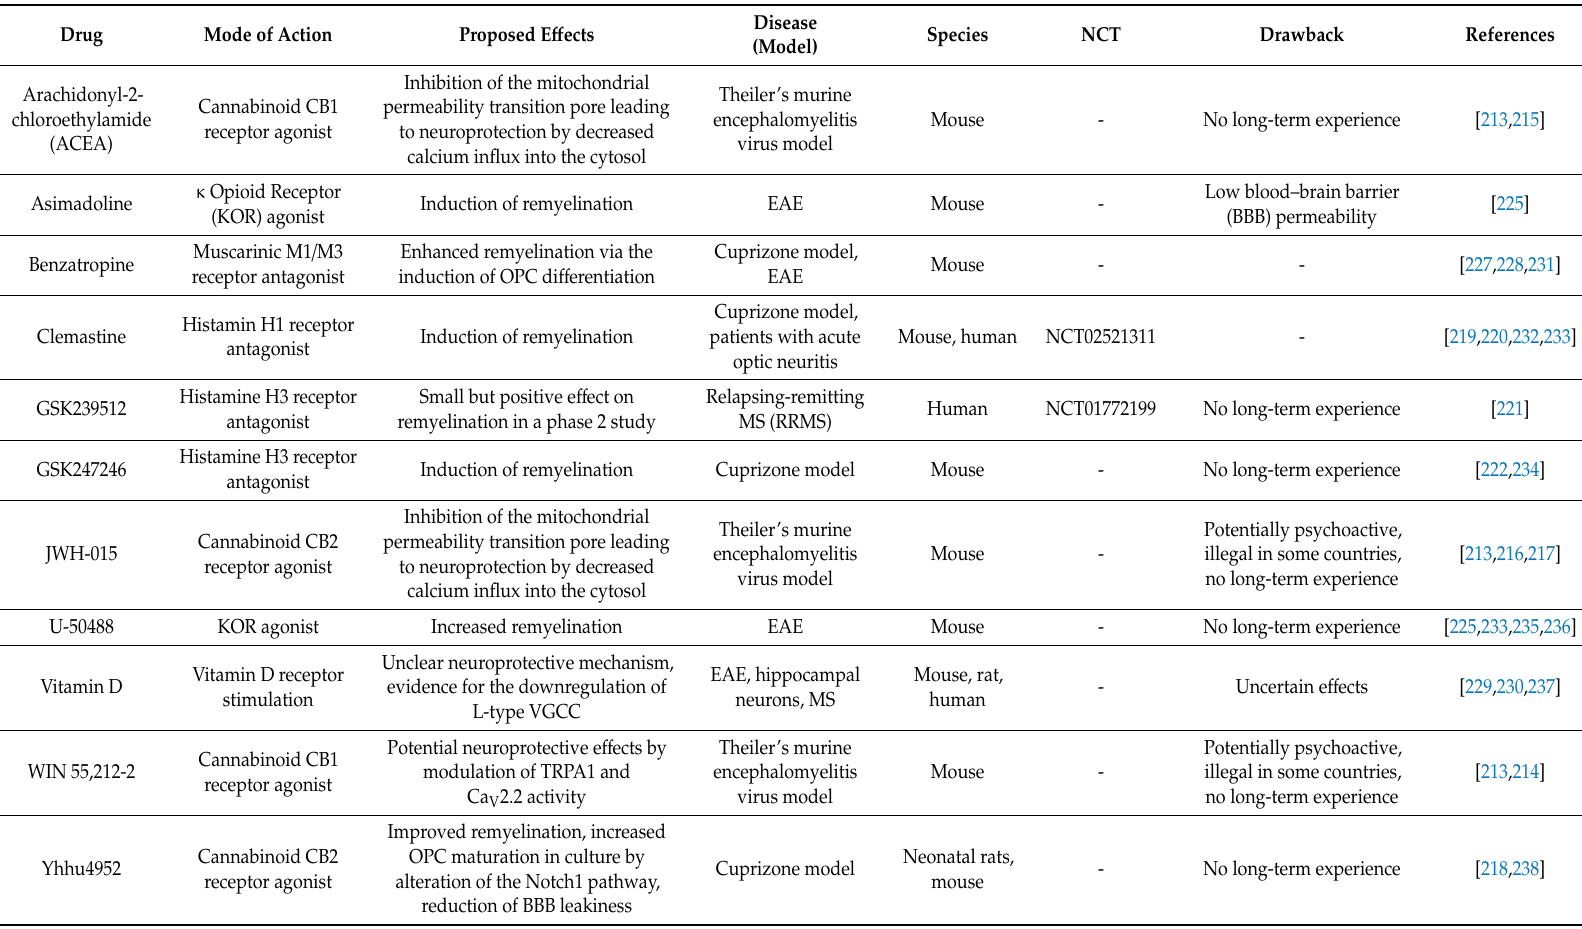
Table 2. Drugs which indirectly interfere with calcium signaling and may potentially be neuroprotective in